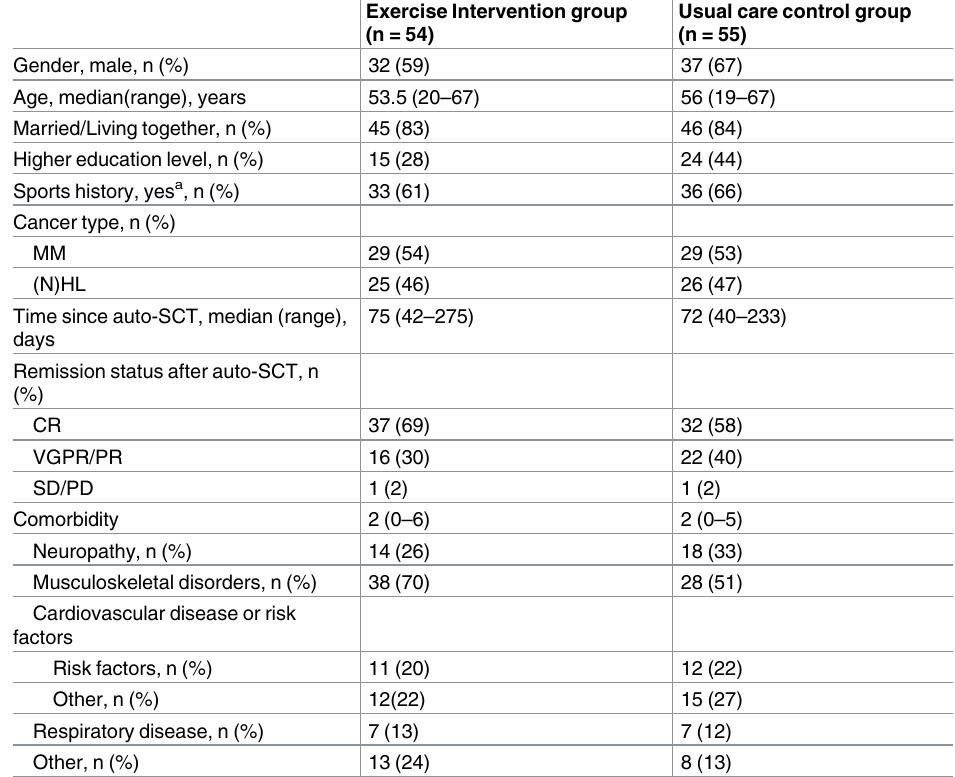
Table 1. Baseline demographics and clinical characteristics of participants in the exerciseinterven- tion and usual care control group.